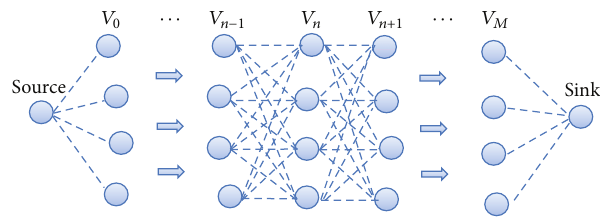
Figure 3: Cooperation between adjacent groups of cooperative